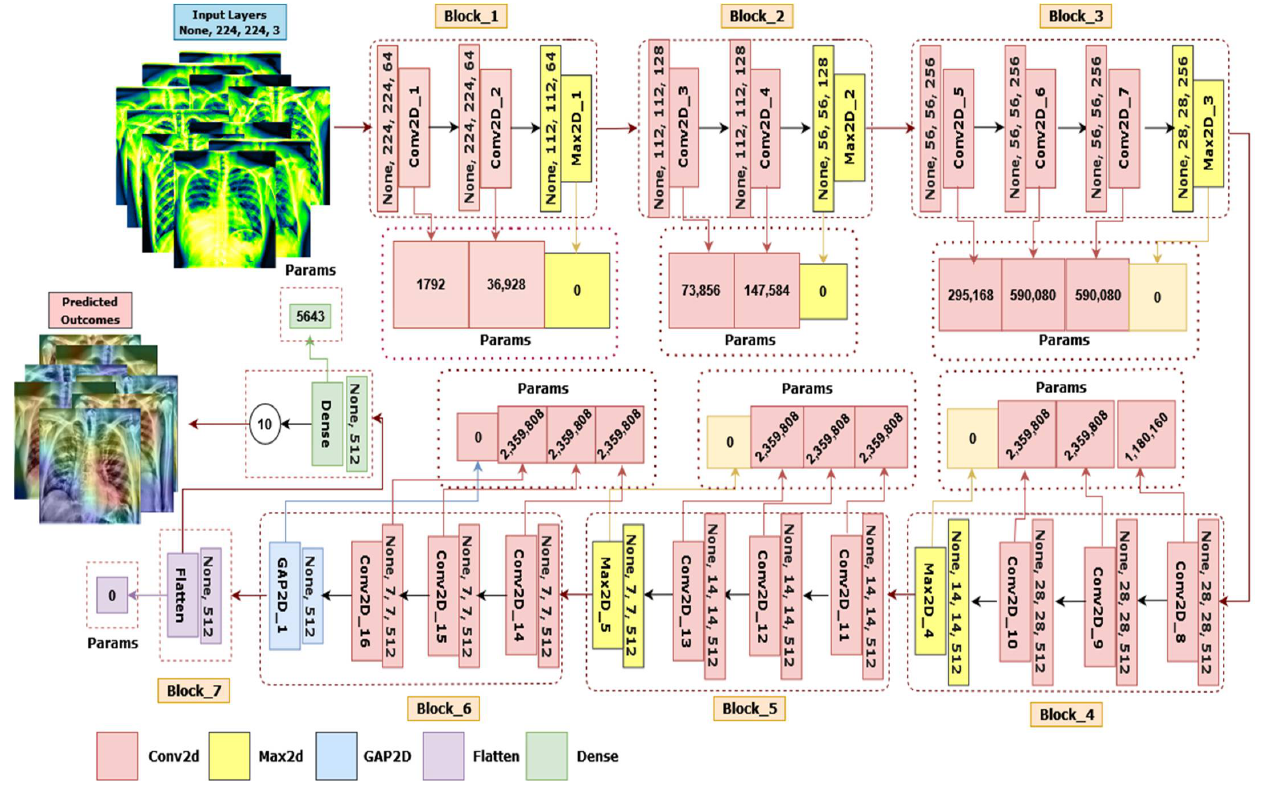
Figure 9. The architecture of LungNet22, a fine-tuned VGG16 network.